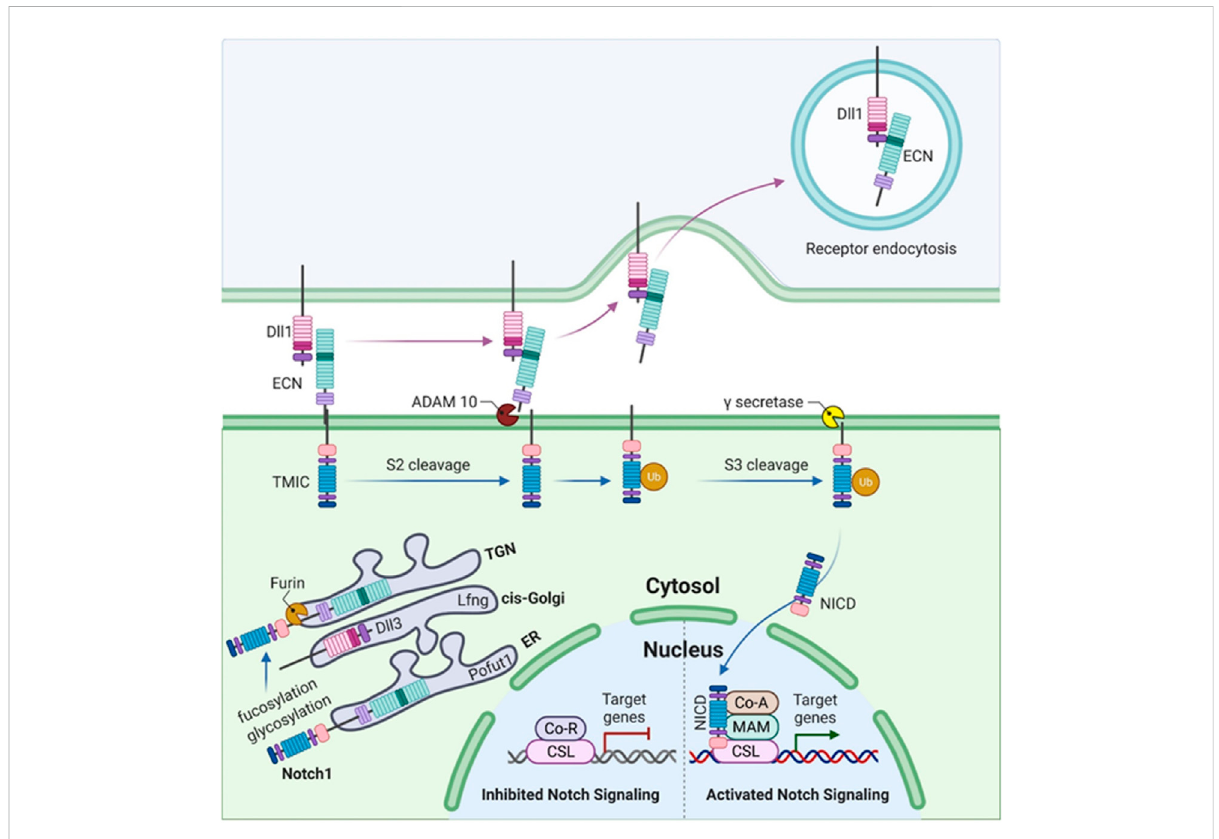
FIGURE 3 SomitogenesisinmammalsillustratingNotch1signaling.The fi gureillustratesthesynthesisofNotch1asasinglepolypeptide.O-fucosylationof speci fi c EGF-like repeats occurs in the endoplasmic reticulum (ER) by O-fucosyltransferase 1 (Pofut1), followed by the elongation of these O-fucosylated EGF-like repeats (upon addition of GlcNAc by lunatic fringe, Lfng) as the Notch1 polypeptide passes through the cis-Golgi. S1 cleavage occurs in the trans-Golgi network (TGN) by a furin-like convertase. The Notch1 heterodimer (composed of an N-terminal extracellular truncation, ECN, and a C-terminal transmembrane and intracellular domain, TMIC) moves toward the cell surface where it binds DLL1 via ECN in trans. This binding leads to the activation of S2 cleavage by the disintegrin and metallopeptidase domain (ADAM) proteases, ADAM10orADAM17.ThisliberatestheNotch1ECNwhichthenundergoesubiquitylation(Ub)andisendocytosed.S3cleavageofNotch1ECNoccurs in the transmembrane domain via γ -secretase which releases the Notch1 intracellular domain (NICD). NICD binds CSL which is a DNA-binding protein. Upon binding to CSL, co-repressor (CoR) proteins and histone deacetylases (HDACs) are released while the binding of coactivators (CoAs) occurssimultaneouslywhichresultsintheactivationofNotchsignaling,leadingtothetranscriptionoftargetgenessuchas MESP2 , LFNG ,and HES7